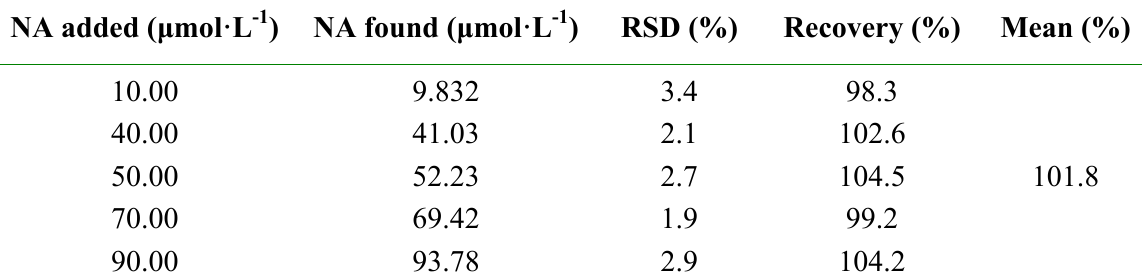
Table 2. Recovery of NA in human urine sample